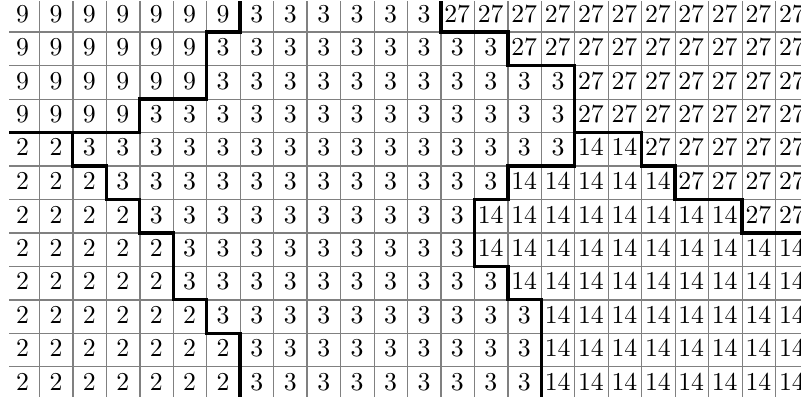
. Grain boundaries are drawn i